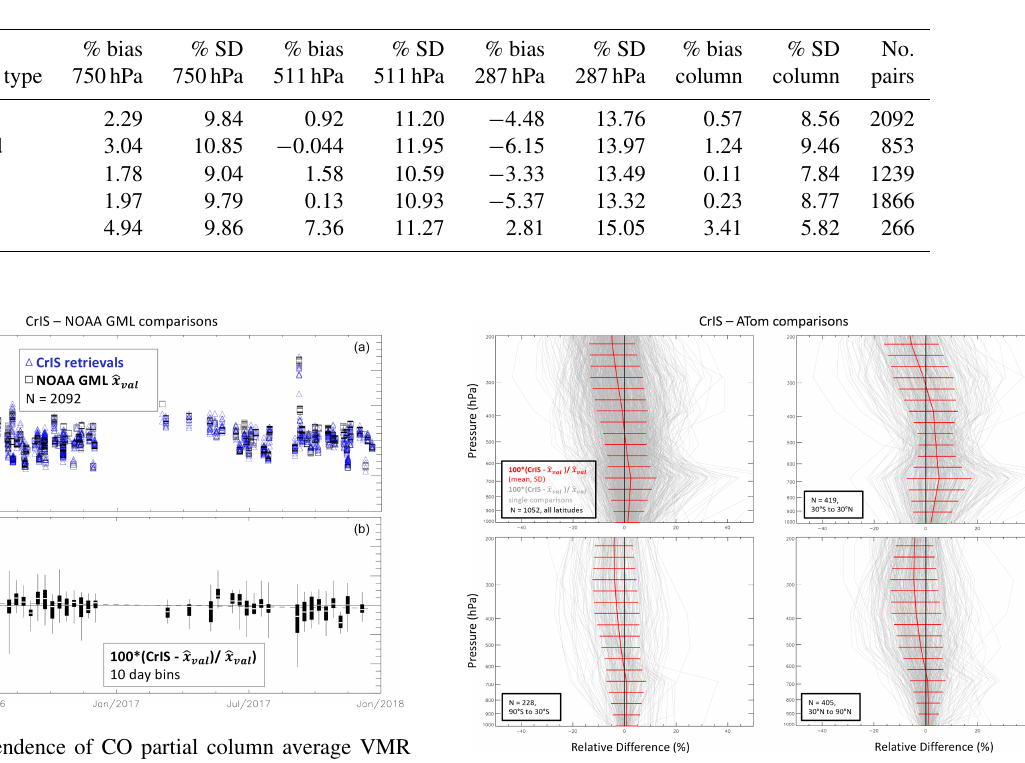
Table 2. Bias and standard deviation (SD) for comparisons of SNPP TROPESS/CrIS CO retrievals and in situ CO profiles from NOAA GML fights.